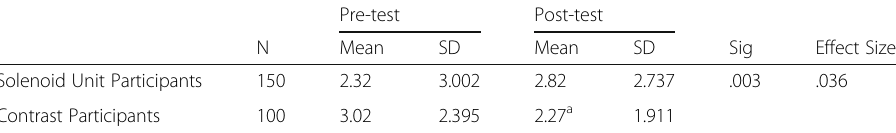
Table 3 One-way repeated measures ANOVA comparing means across groups on the Solenoid